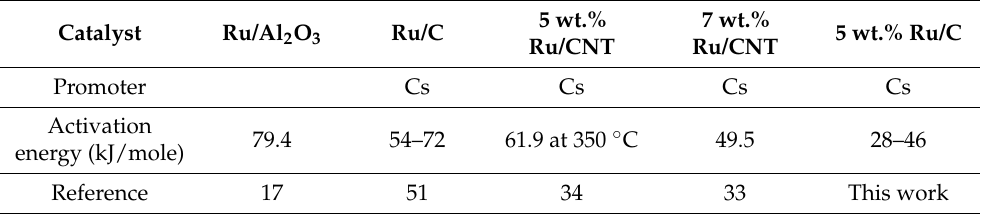
Figure 8. The variation of the H 2 production rate (in ln scale) with the temperature. Table 2. The comparison of activation energy between different Ru-based